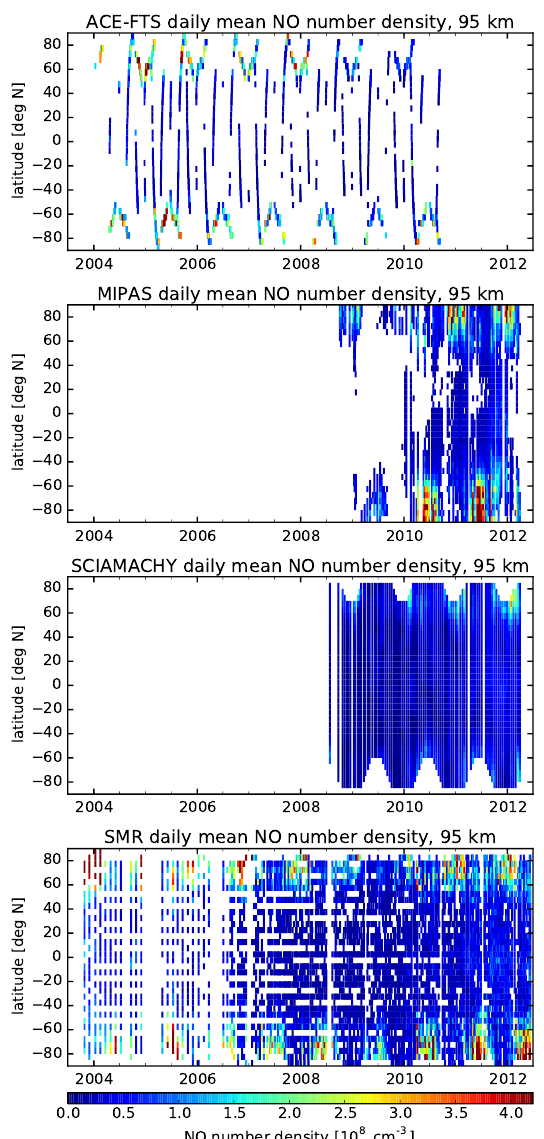
Figure A4. NO zonal mean time series at 105km from ACE-FTS, MIPAS, SCIAMACHY, and SMR (from top to